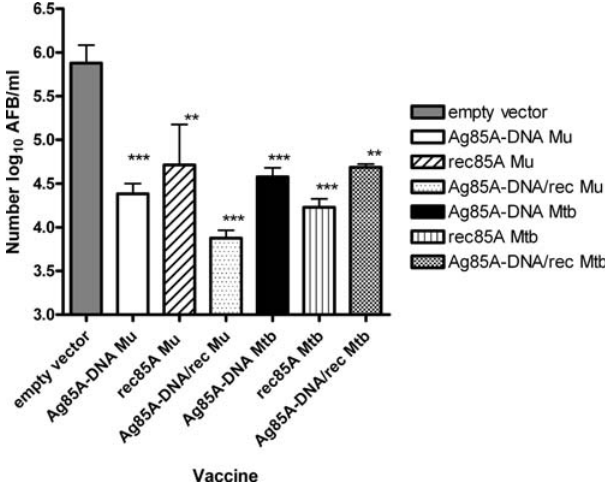
Figure 5. Mycobacterial multiplication in mice infected with M. ulcerans strain 04-855. Mice infected three months after the last vaccination (protocol 1 using Gerbu adjuvant). Results are mean 6 SD of AFB/ml of 4 individual mice, expressed in Log 10 . * p value as compared to mean log 10 value obtained in control DNA mice infected with M. ulcerans.